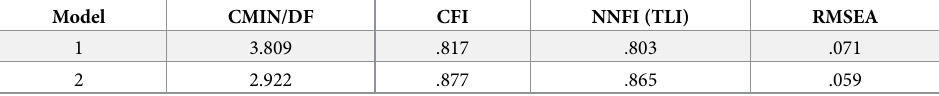
Table 2. CFA fit indices of assessed models (Stage 3). CMIN/DF—Relative chi-square; CFI -comparative fix index; NNFI (TLI)—non-normed fit index; RMSEA—root mean square error of